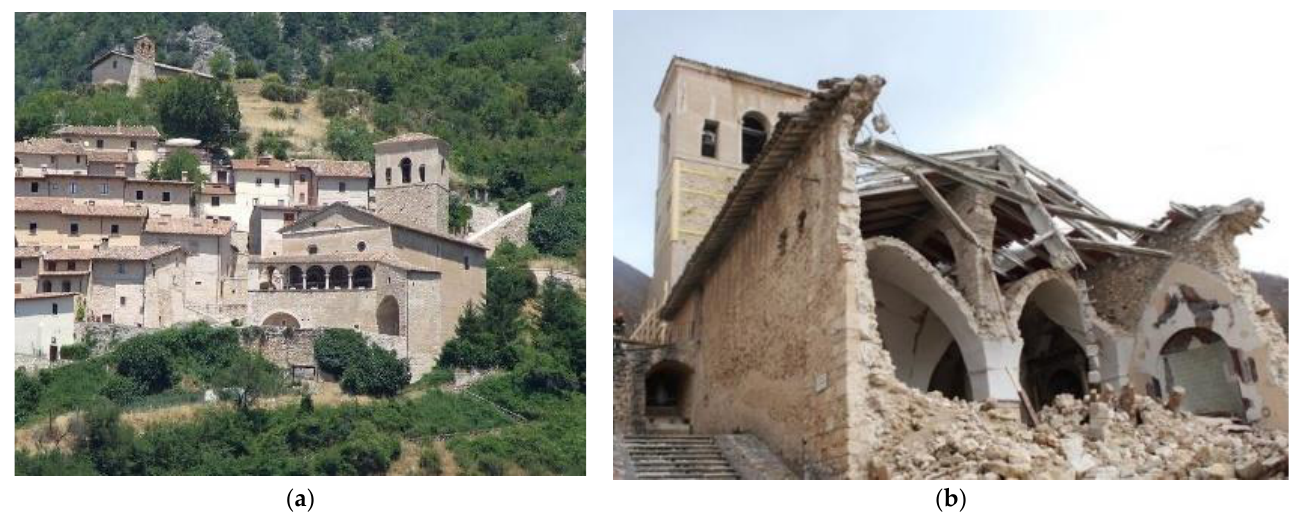
Figure 3. ( a ) The church of Sant ’ Andrea, with its bell tower and portico, prior to the 2016 earthquake. ( b ) The church following the collapses related to the 2016 earthquake. The high-precision 3D model of the church generated from these can support: